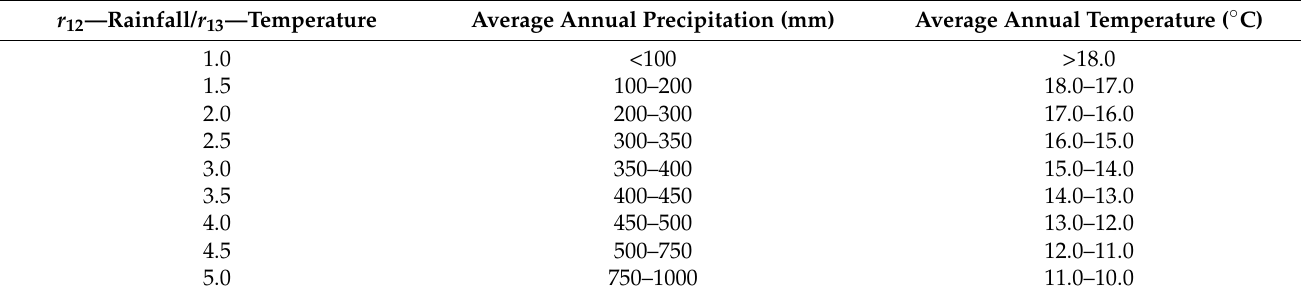
Table 4. Relationship between average annual precipitation, average annual temperature, and valuation of the atmospheric input parameters ( r 12 —rainfall; r 13 —temperature)